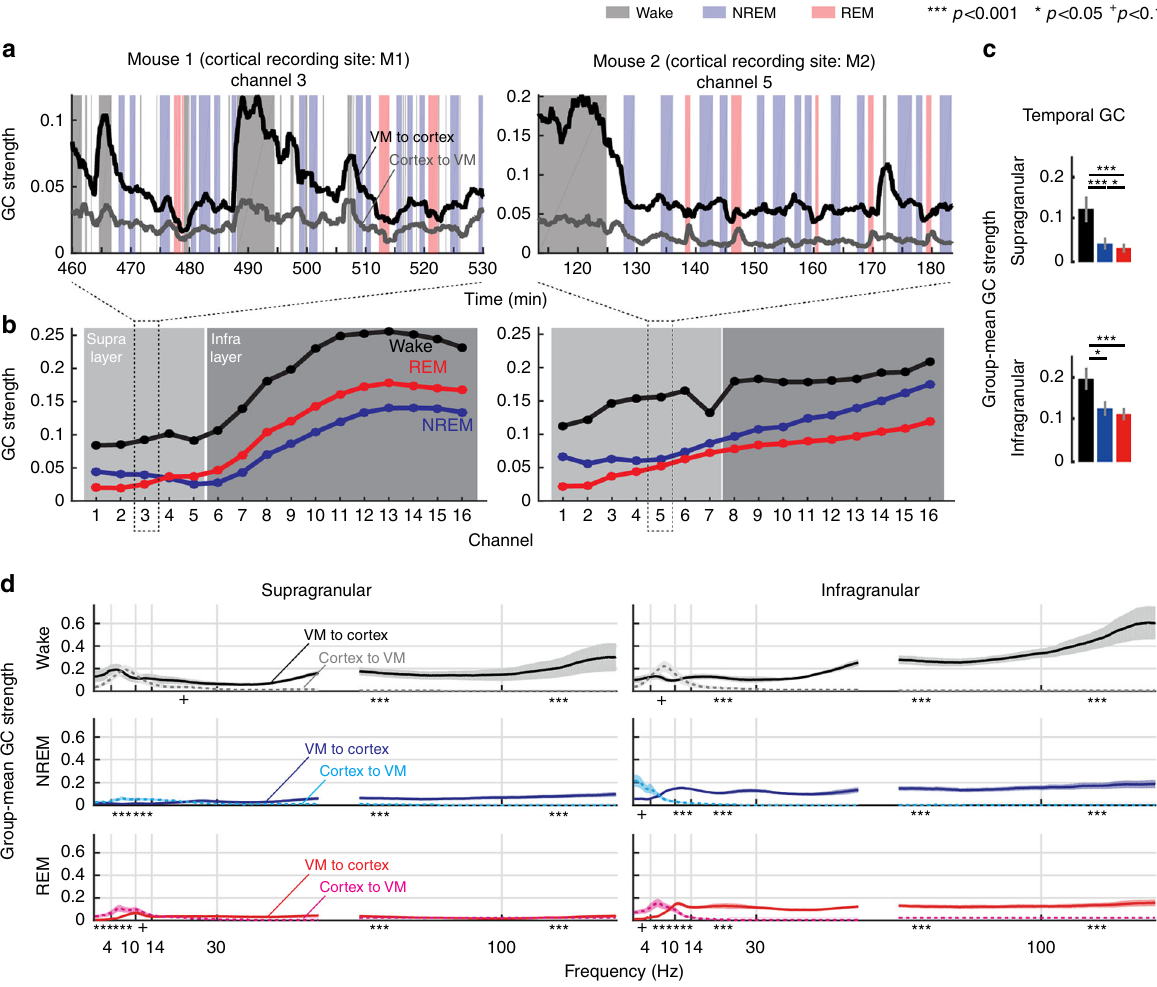
Fig. 4 Optogenetic activation of VPM neurons does not affect vigilance states. a Coronal section of the mouse brain (Bregma − 1.6 A/P) showing a representative example of virus expression in VPM (AAV2-Cre and AAV5-DIO-SSFO). Cortical projection is strongest in the middle layer. Scale bar = 1 mm. b Example of VPM optogenetic stimulation in NREM sleep, showing the 10 s before and after laser onset. Red open squares identify OFF periods. The blue bar indicates when the light is on. The 5-s pulse gradually increases VPM unit fi ring, with the effect becoming even stronger after light off (VPM MUA and ticks, thresholded spikes). EEG and LFP show lower amplitude at the time of stimulation, but despite strong tonic VPM fi ring slow waves (*) quickly reappear, associated with increased SWA (top panel). Both EMG signals are unaffected. c Example of VPM stimulation in REM sleep. * indicates a sporadic whisker movement. d CDF plots of automatically detected latency to awakening after VPM stimulation (left) and manually scored duration of wake